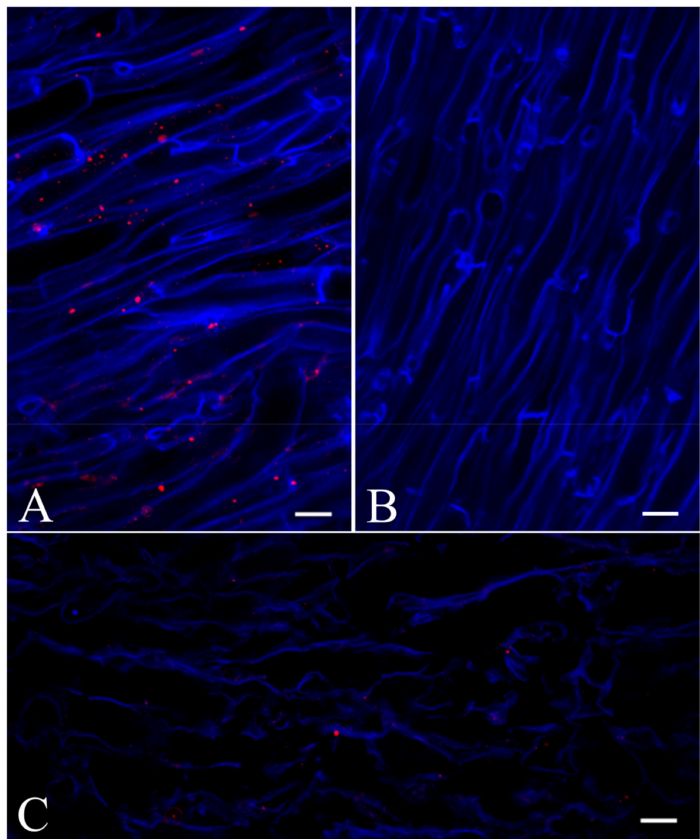
Figure 6. Immunolocalization of Ageritin on cryo-sections of A. aegerita ( A , B ) and of Agaricus campestris ( C ) by confocal laser scanning microscope. A clear positive signal is present in form of dots inside hyphae of A. aegerita ( A ) but not in A. campestris ( C ) that does not synthesize this compound, except for a few background; labelling is also lacking in ( B ), a negative control in which the rabbit antiserum against Ageritin is missing. All bars are equals to 20 µ m.